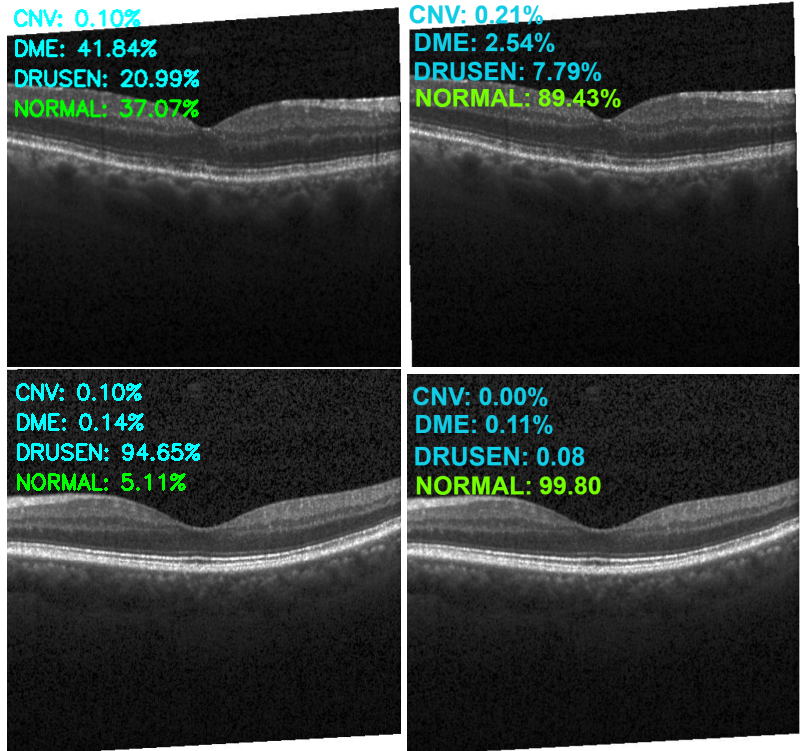
Figure 16. Exemplary result of proposed model trained without (left column) and with (right column) augmentation (correct label highlighted in